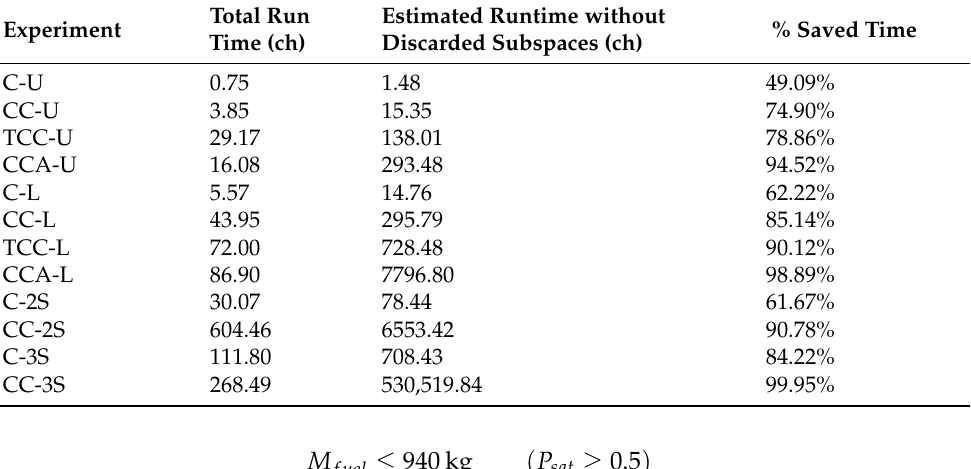
Table 9. Comparison between the actual computational time and the estimated one without the probabilistic exploration.